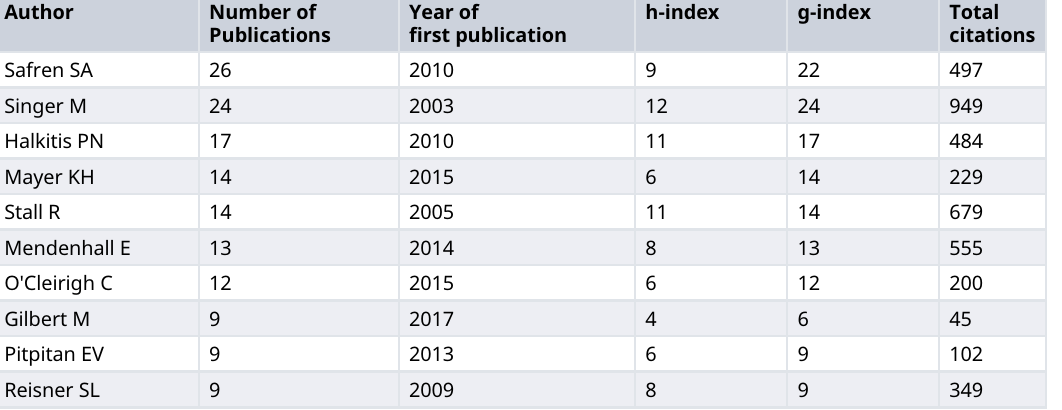
Table 3. Top ten authors contributing to syndemics research.